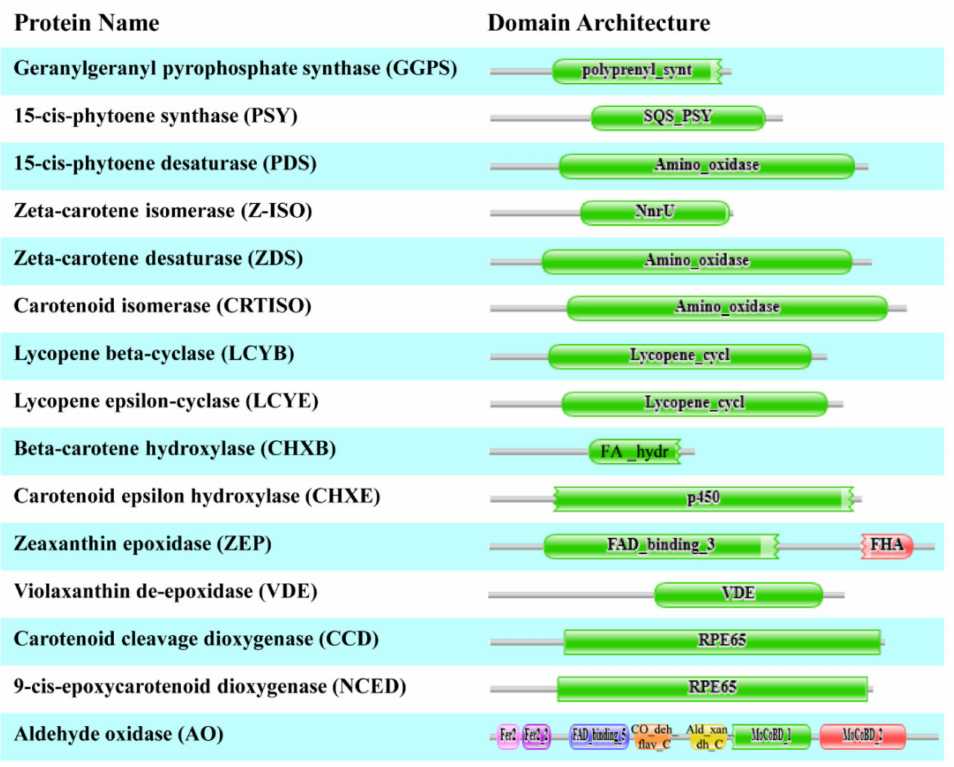
Figure 2. The conserved domain of 15 CP, XP, and AP genes in H. moellendorffii